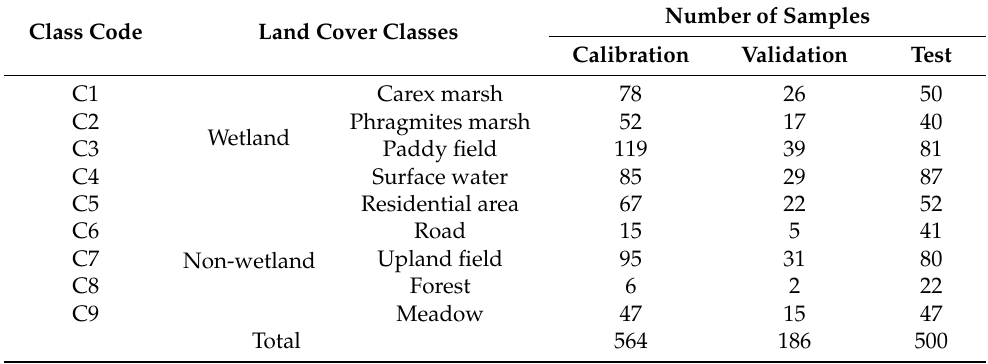
Table 2. Number of collected samples for the land cover classes over the study